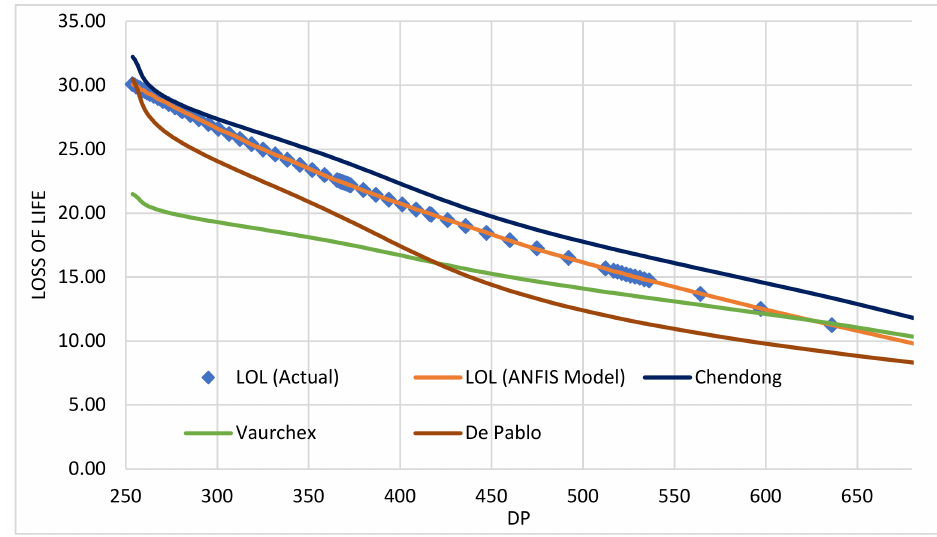
Figure 3. Databank: LOL vs.